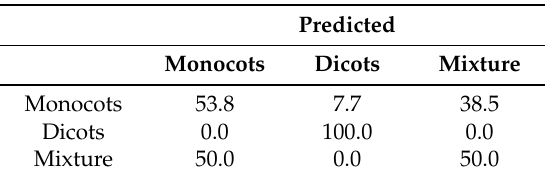
Table 1. Confusion matrix of the canonical discriminant classification showing a percentage of correct group classifications for the three predefined